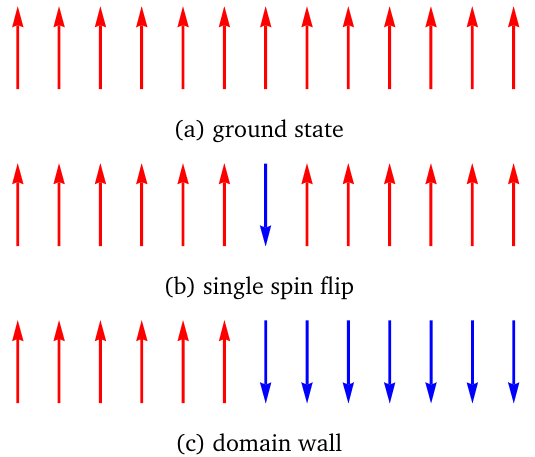
Figure 6.3: Top: the ferromagnetic ground state of the one-dimensional Ising model. Centre: a single spin flip, which only marginally affects the total magnetisation. Bot- tom: a single domain wall, which is a topological defect with macroscopic effect on the total magnetisation. In one dimension, the domain wall has lower energy than the spin